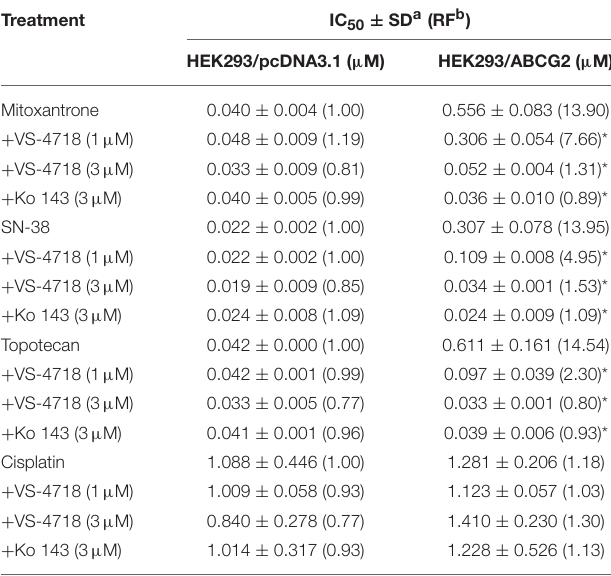
TABLE 5 | VS-4718 did not affect ABCC1-mediated MDR.